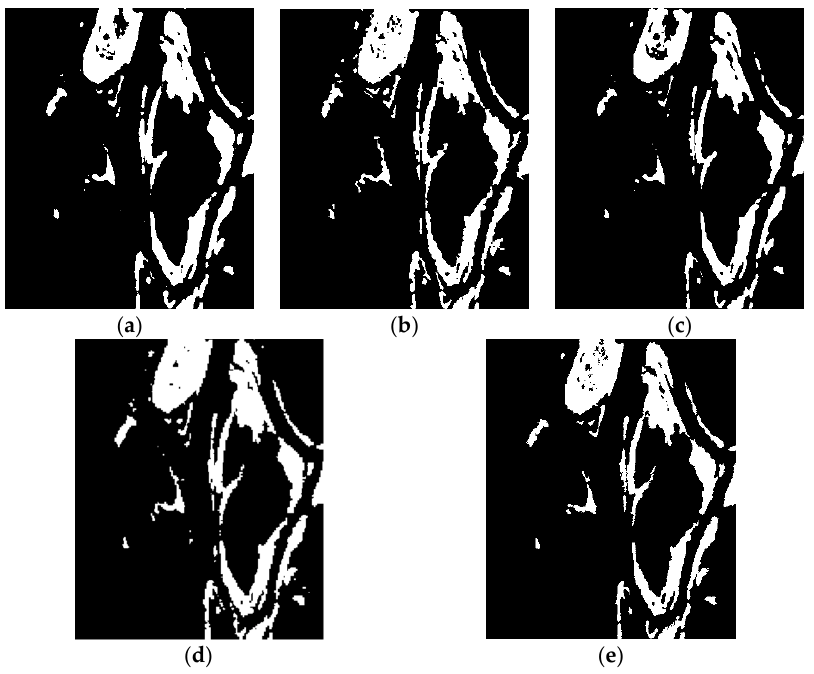
Figure 12. Change detection results generated by different methods on the Ottawa dataset. ( a ) Result by PCAKM. ( b ) Result by MRFFCM. ( c ) Result by GaborTLC. ( d ) Result by D_MRFFCM. ( e ) Result by the proposed method. Table 3. Change detection results of different methods on the Ottawa dataset.